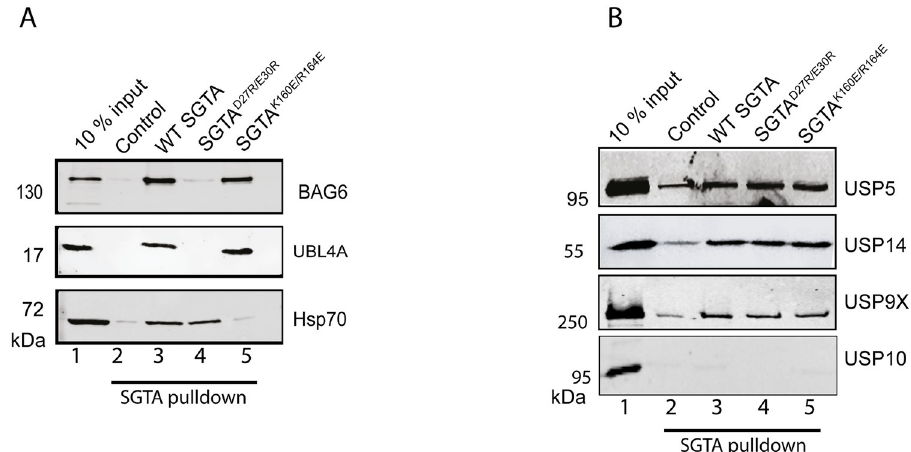
Fig 1. Identification of SGTA interacting DUBs. A) Beads coupled to recombinant Thioredoxin-SGTA fusion proteins as indicated or Thioredoxin only (Control) were incubated with rabbit reticulocyte lysate for 16 hours at 4˚C. The beads were washed as detailed in Materials and Methods. Twice the bead volume of SDS sample buffer was added, and samples were processed for SDS PAGE and Western blotting and probed with antibodies against Bag6, UBL4A and Hsp70 proteins using a fluorescence- based Odyssey 1 Fc Imaging System (LICOR). B) Beads described in A, were incubated with HeLa lysate for 16 hours, washed and processed for Western blotting as detailed in A. Blots were probed with antibodies against USP5, USP14, USP9X and USP10 proteins using fluorescence- based detection on an Odyssey 1 Fc Imaging System (LICOR).